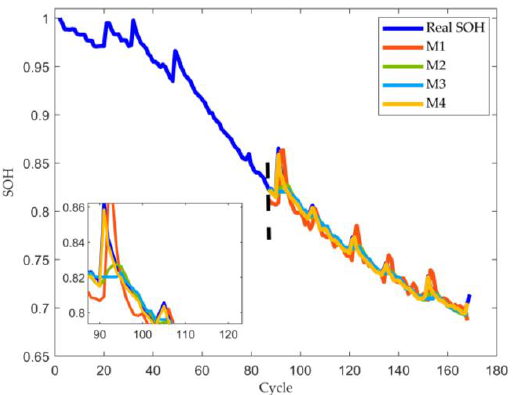
Figure 10. Different models of SOH prediction results for B0005.